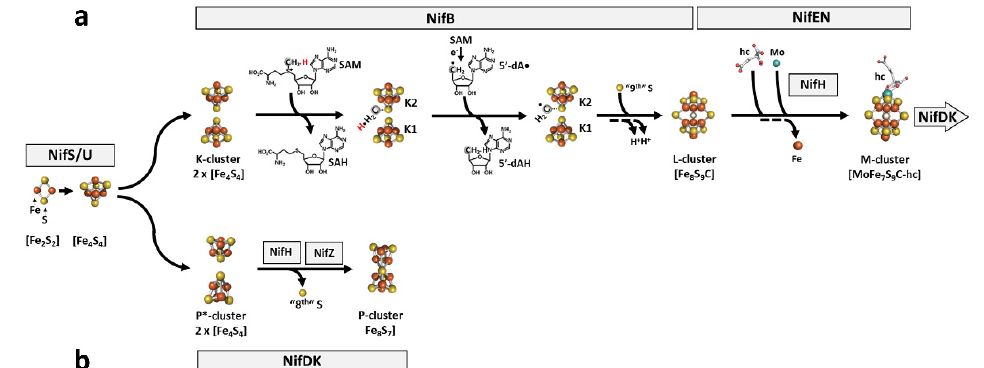
Figure 9. Biosynthesis of the complex metalloclusters of Mo-nitrogenase. Shown are ( a ) the “ ex situ ” assembly of the M-cluster, where NifH serves as a Mo/homocitrate (hc) insertase to mature the L-cluster ([Fe 8 S 9 C]) into a fully assembled M-cluster ([( R -homocitrate)MoFe 7 S 9 C]) on NifEN; and ( b ) the “ in situ ” assembly of the P-cluster, where NifH serves as a reductase to facilitate the reductive coupling of a P*-cluster (an [Fe 4 S 4 ]-like cluster pair) into a fully assembled P-cluster ([Fe 8 S 7 ]) on NifDK. Note that the assembly pathways of M- and P-clusters share the early steps that involve the sequential formation of [Fe 2 S 2 ] and [Fe 4 S 4 ] clusters by the concerted actions of NifS and NifU. The two pathways branch after these early events, with a pair of [Fe 4 S 4 ] clusters (K-cluster), delivered to NifB for the formation of an M-cluster, and a pair of [Fe 4 S 4 ] clusters (P*-cluster) delivered to NifDK for the formation of a P-cluster. The biosynthetic events on NifB involve radical SAM-dependent coupling of the two 4Fe units of the K-cluster (designated K1 and K2) into an 8Fe L-cluster concomitant with the insertion of a “9th sulfur” ( a ); whereas the biosynthetic events on NifDK involve the stepwise formation of the two P-clusters in the two αβ -halves of NifDK via reduction coupling of the two 4Fe units of the P*-cluster into an [Fe 8 S 7 ] P-cluster concomitant with the removal of an “8 th sulfur” ( b ).